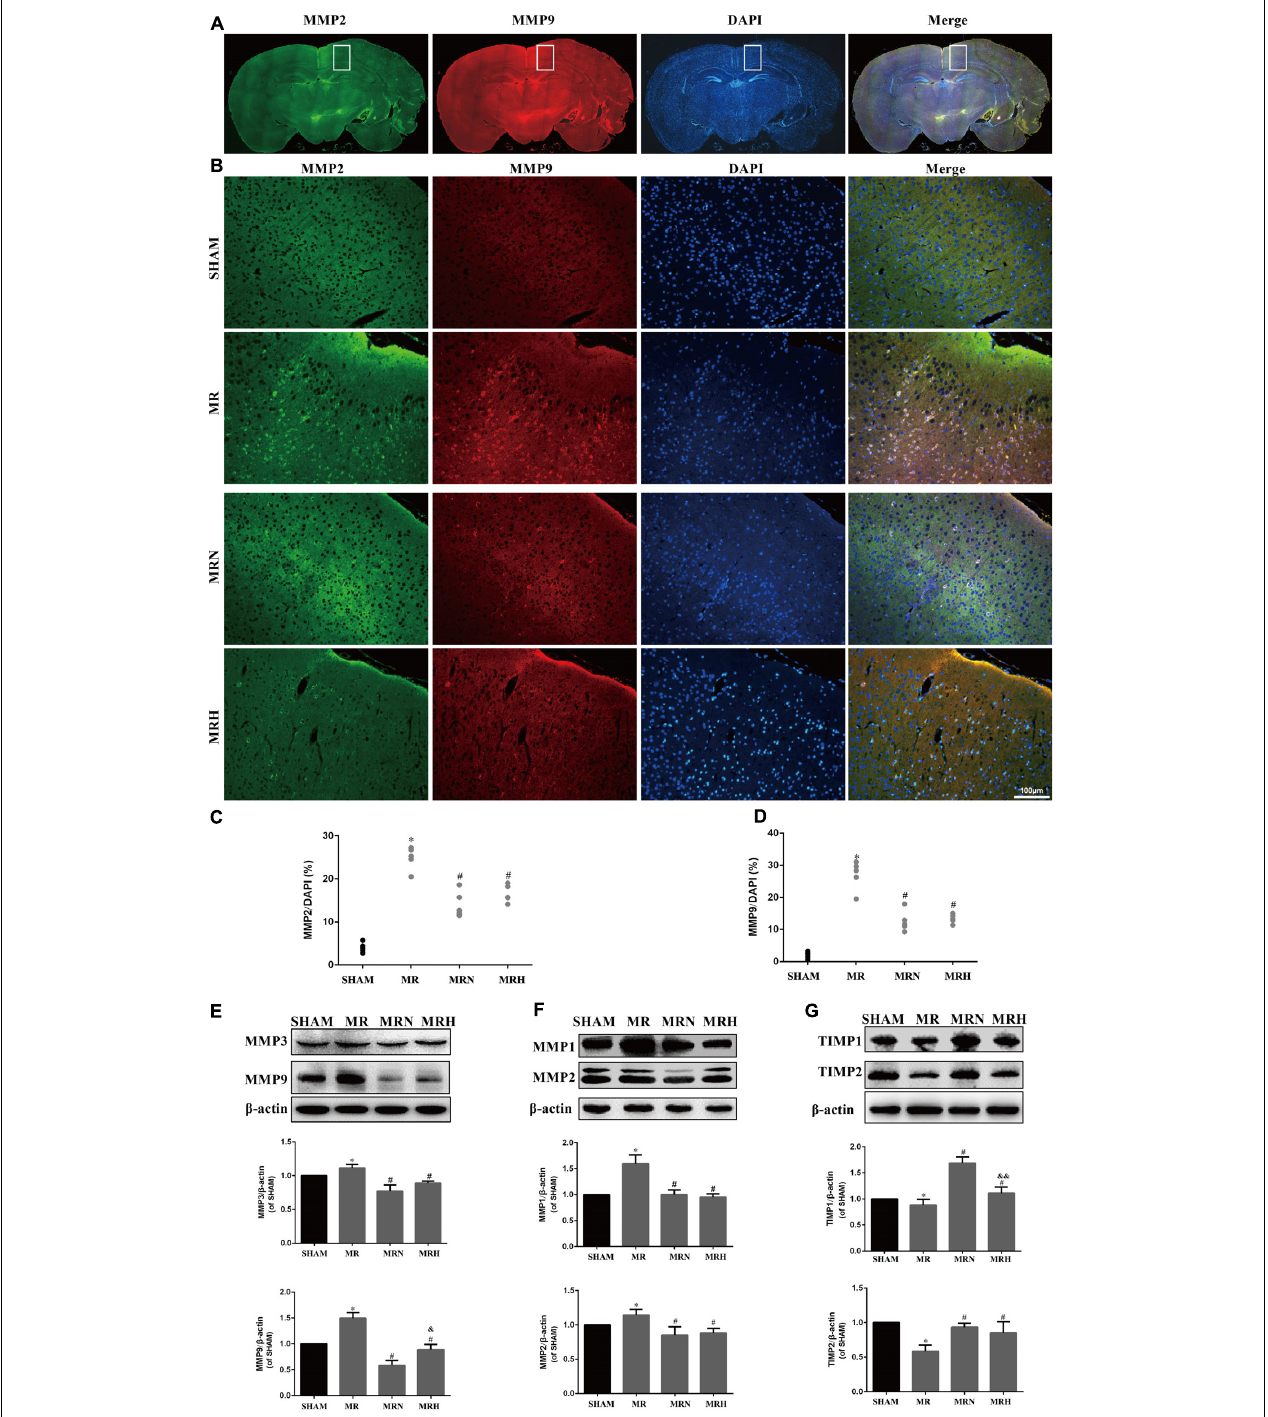
FIGURE 4 | Rosuvastatin reduced MMP expression and increased TIMPs expression in peri-infarct regions. (A) Representative images show MMP-2 (green) and MMP-9 (red) in the MR group; DAPI was used to stain the cell nuclei. The white box magnified in (B) shows the peri-infarct regions. The magnified images show MMP-2 and MMP-9 staining in the peri-infarct regions in SHAM, MR, MRN, and MRH groups (scale bar = 100 µ m). (C,D) The MMP-2-labeled particle numbers (green)/DAPI (blue) and MMP-9-labeled particle numbers (red)/DAPI (blue) are presented as the means + SEM ∗ P < 0.05 compared to the SHAM group, # P < 0.05 compared to MR group, n = 6. (E–G) Immunoblots were used to test MMP-3, MMP-9, MMP-1, MMP-2, TIMP-1, and TIMP-2 levels in the peri-infarct regions. Similar results from six independent experiments are shown by representative blots and statistical charts. Data are presented as the means + SEM and were analyzed by one-way ANOVA. ∗ P < 0.05 compared to SHAM, # P < 0.05 compared to MR, & P < 0.05, && P < 0.01 compared to MRN.